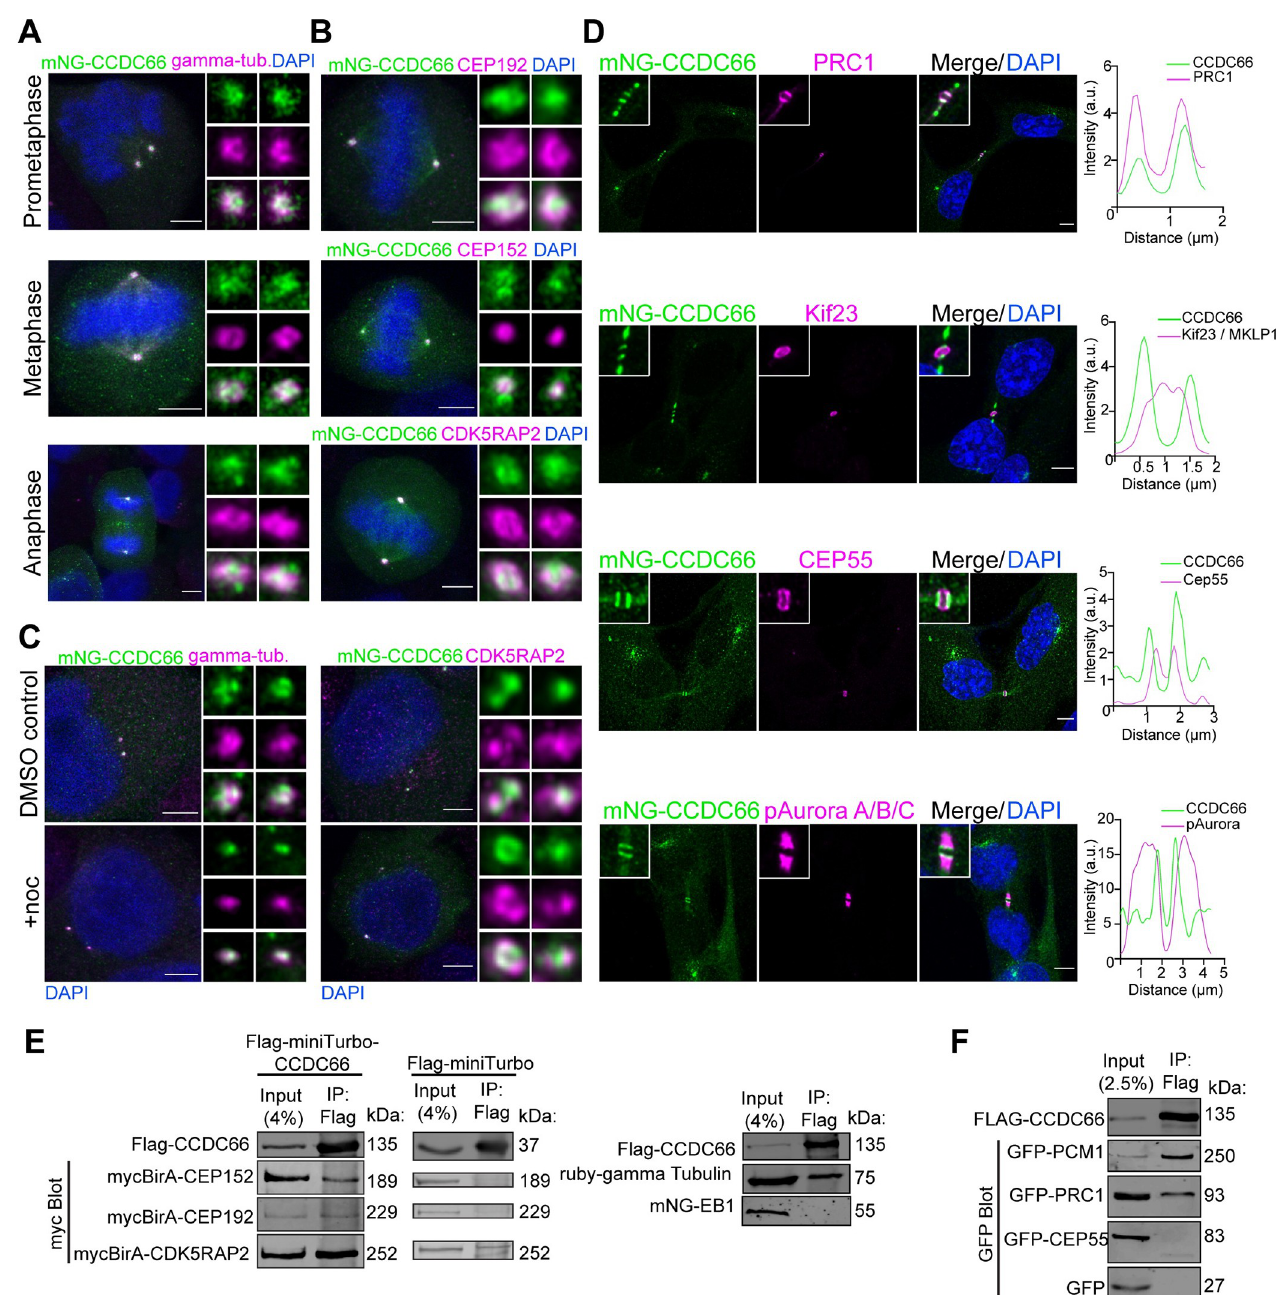
Fig 2. CCDC66 co-localizes and interacts with PCM proteins and spindle/midbody MAPs. (A) mNG-CCDC66 localizes to the centrosome throughout the cell cycle. U2OS::mNG-CCDC66 cells were fixed with 4% PFA and stained for gamma-tubulin and DAPI. Still deconvolved confocal images represent centrosomal co-localization of mNG-CCDC66 with gamma-tubulin during different stages of cell division. Scale bar: 5 μ m, insets show 4 × magnifications of the centrosomes. (B) Localization of mNG-CCDC66 in U2OS cells relative to PCM proteins. U2OS::mNG-CCDC66 cells were fixed with 4% PFA and stained for CEP192, CEP152, or CDK5RAP2 and DAPI. Deconvolved confocal images represent their relative localization at the centrosomes during metaphase. Scale bar: 5 μ m, insets show 4 × magnifications of the centrosomes. (C) Effect of microtubule depolymerization on CCDC66 localization at the centrosome. U2OS:: mNG-CCDC66 cells were treated with 0.1% DMSO or 5 μ g/ml nocodazole for 1 h. Cells were then fixed with 4% PFA and stained for gamma-tubulin or CDK5RAP2 and DAPI. Scale bar: 5 μ m, insets show 4 × magnifications of the centrosomes. (D) Localization of mNG-CCDC66 in RPE1 cells relative to midbody proteins. RPE1::mNG-CCDC66 cells were fixed with methanol and stained for mNeonGreen and PRC1, Cep55, Kif23 (MKLP1), or pAurora A/B/C and DAPI. Graphs show the plot profiles to assess co-localization with the indicated marker. Using ImageJ, a straight line was drawn on the midbody and intensity along the distance was plotted on Graphpad Prism. (E) Co-immunoprecipitation of Flag-miniTurbo-CCDC66 or Flag-miniTurbo with PCM proteins